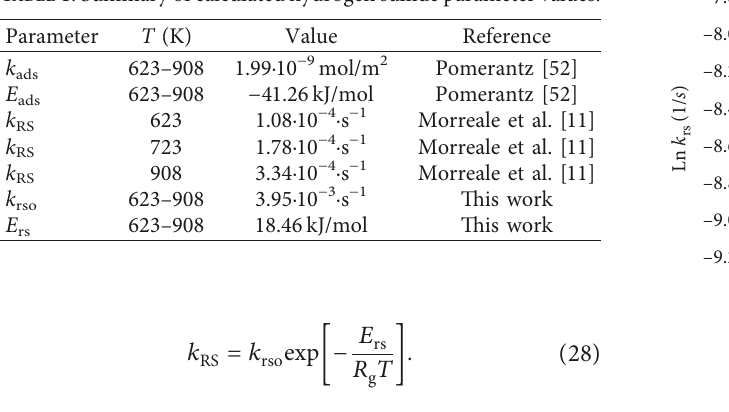
Figure 5: Kinetic parameters results.